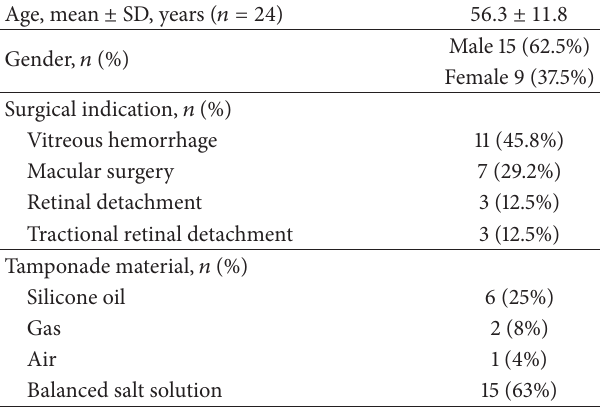
Table 1: Patient demographics.